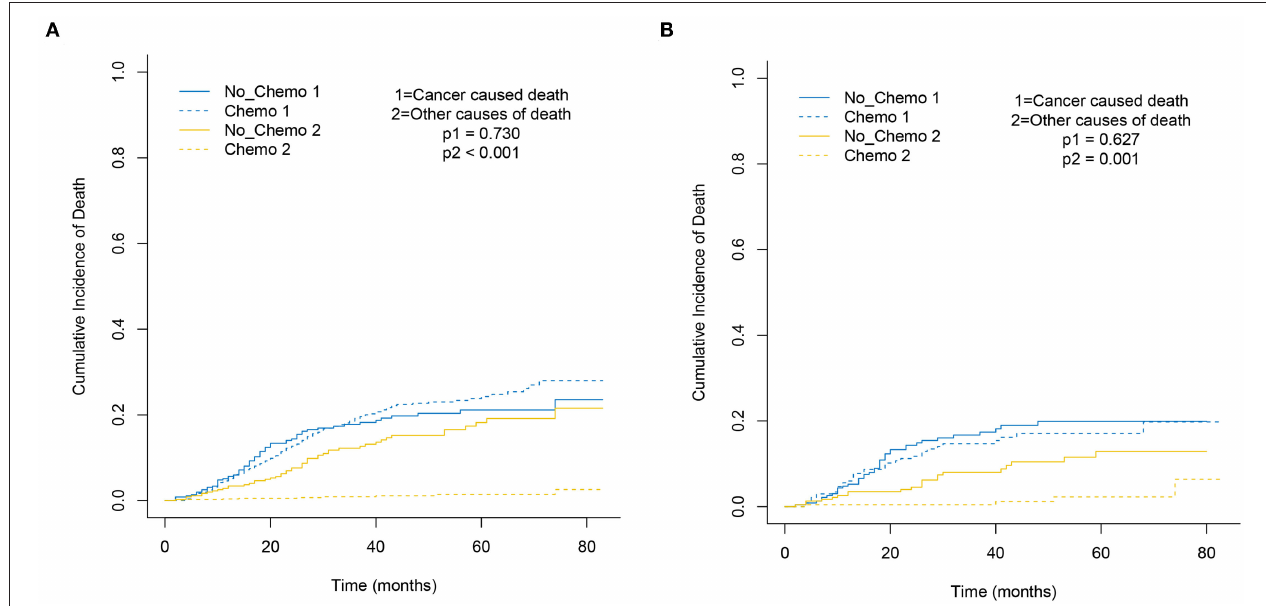
FIGURE 1 | Cumulative incidence plot depicting cancer-caused death and other cause mortality based on chemotherapy before (A) and after (B) PSM.